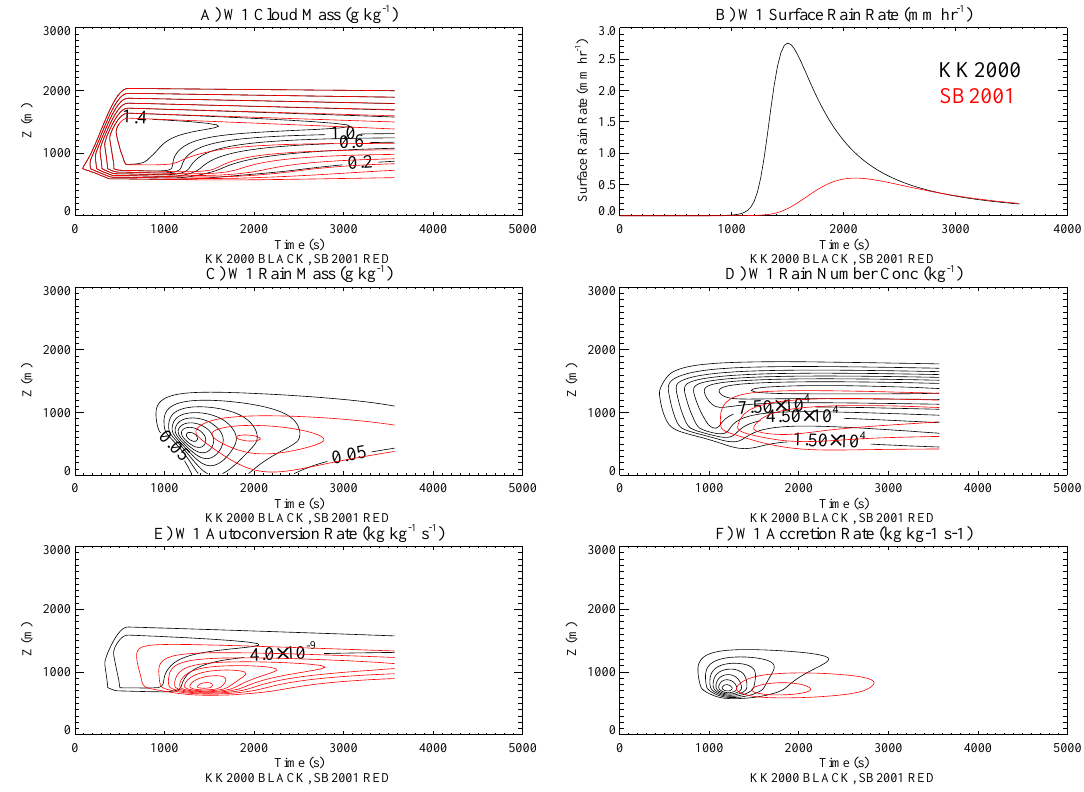
Figure 4. Warm 1 (W1) single updraft case results with cloud drop number concentration of 200cm − 3 for (a) cloud liquid mass (contour interval 0.2gkg − 1 ), (b) surface precipitation rate, (c) warm rain mass (contour interval 0.05gkg − 1 ) and (d) rain number (contour interval 1 . 5 × 10 4 kg − 1 ), (e) autoconversion rate (contour interval 4 × 10 − 9 kg − 1 ) and (f) accretion rate (contour interval 3 × 10 − 9 kg − 1 ) from MG2 with KK2000 (black) and SB2001 (red).